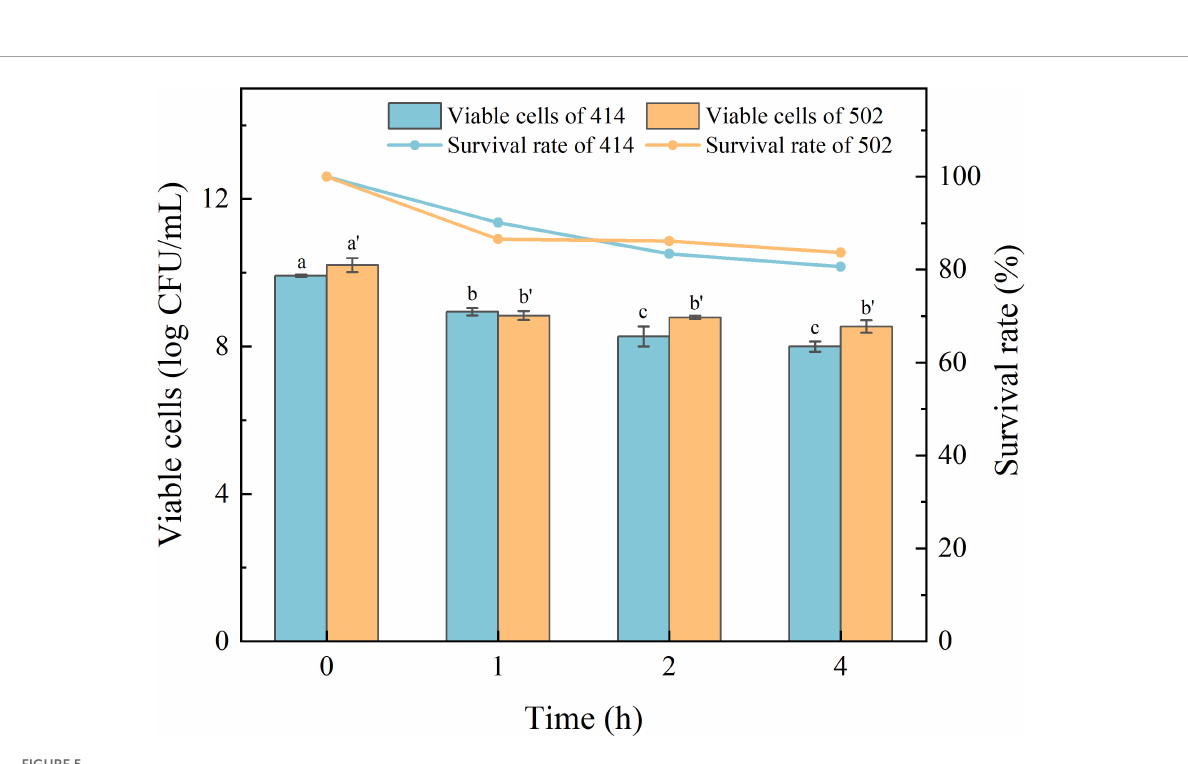
FIGURE5 The survival rate of WFC 414 and WFC 502 cells incubated in simulated intestinal juice for 1, 2, and 4 h. Different letters (a, b, c or a’, b’) indicate significant differences at p < 0.05. Error bars show standard